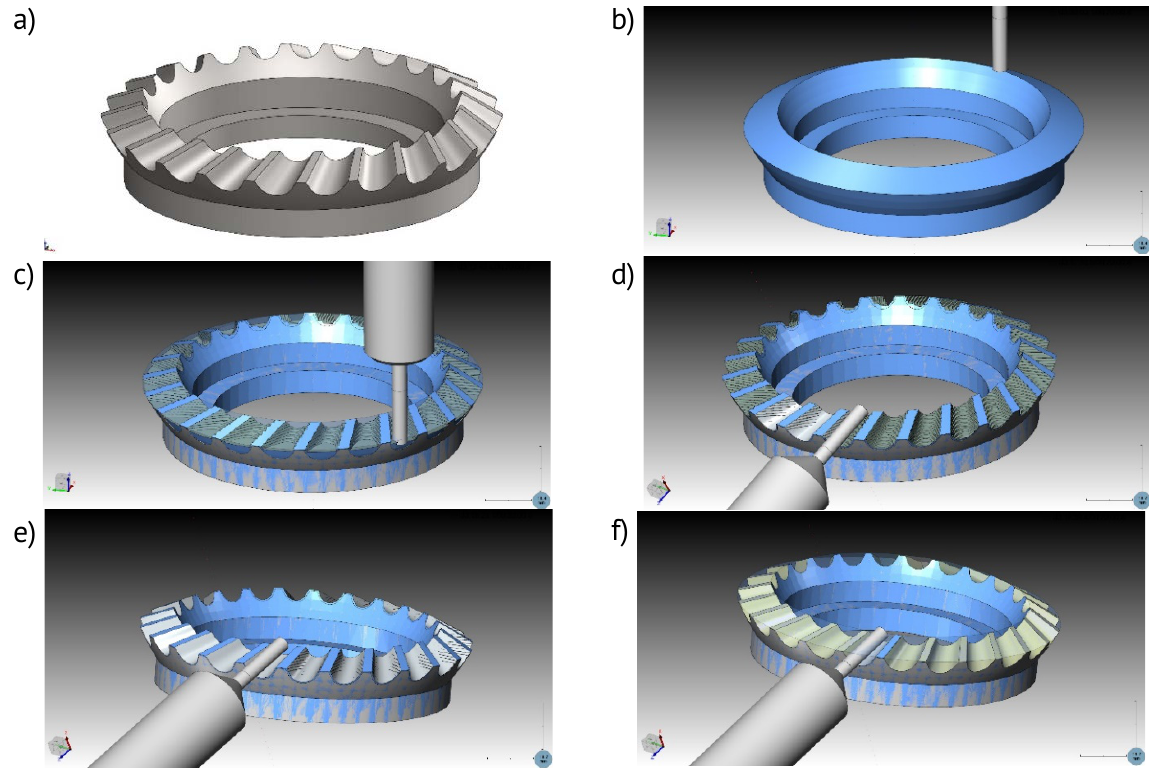
Figure 5. Manufacturing phases based on CAM modelling of the central toothed wheel with inclined teeth: CAD model (a); positioning of the blank (b); roughing of the toothed crown in 3 axes (c); 5-axis machining of the flank surface, preventive (d), intermediate (e) and final